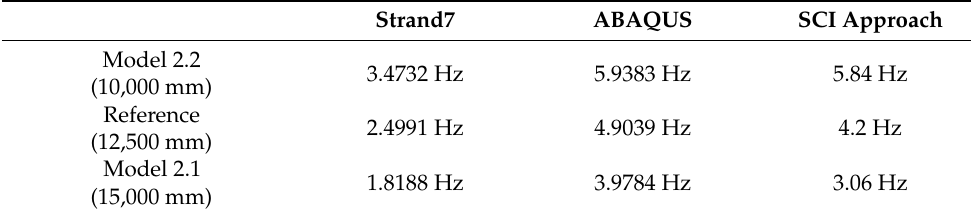
Table 7. Comparison of Fundamental Frequency between Different Primary Beam